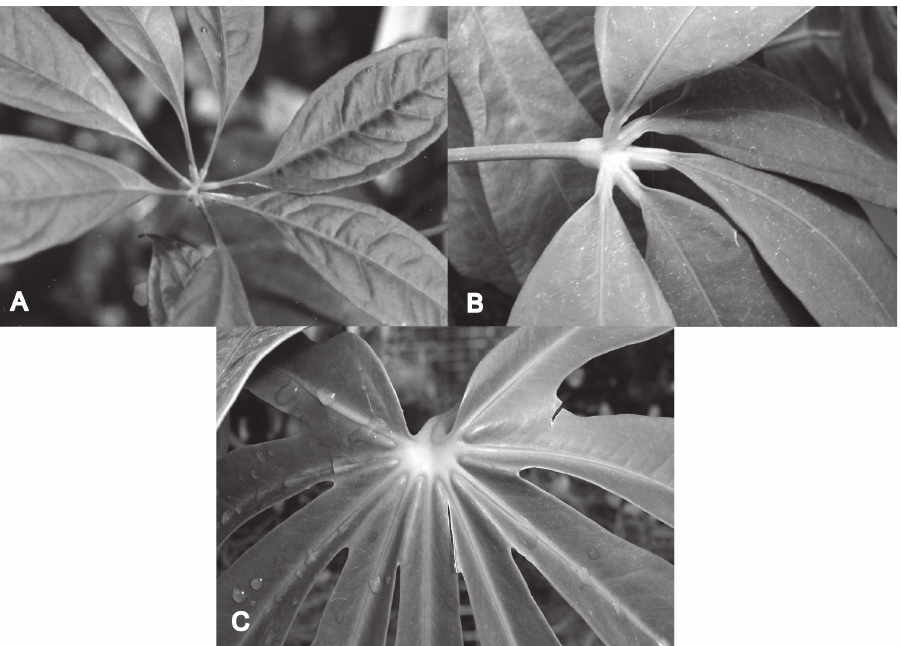
Figure 2. Detail of leaf bases of Anthurium species with palmately divided leaves. A Palmatisect leaf with segments (leaflets) free to the base with long petiolules, Anthurium kunthii Poepp. var. kunthii ( J.P. Folsom 3228 ) B Palmatisect leaf with segments (leaflets) free to the base with short petiolules, Anthurium penta- phyllum (Aubl.) G.Don var. pentaphyllum ( R.M. Harley 18334 ) C Palmatifid leaf with segments (lobes) united at the base, Anthurium palmatum (L.) Schott (Kew living collection